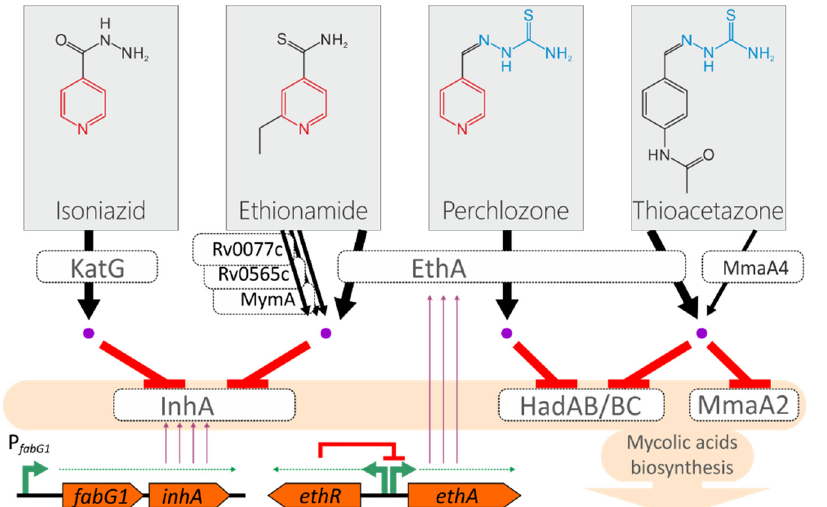
Figure 1. Model of the action of isoniazid, ethionamide, perchlozone, and thioacetazone on M. tu- berculosis . The pyridine and thiosemicarbazone groups are marked with red and blue, respectively. Active forms of the drugs are shown as purple dots. The transcription of the inhA gene is driven by the promoter located upstream of the fabG1 gene. The ethA gene that encodes monooxygenase is under transcriptional regulation by the EthR repressor.